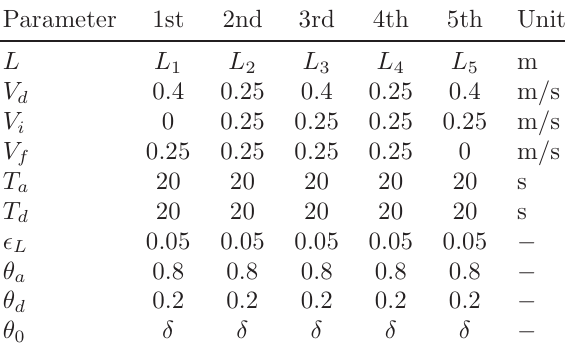
Table 2: Tuning parameters of the RM Parameter